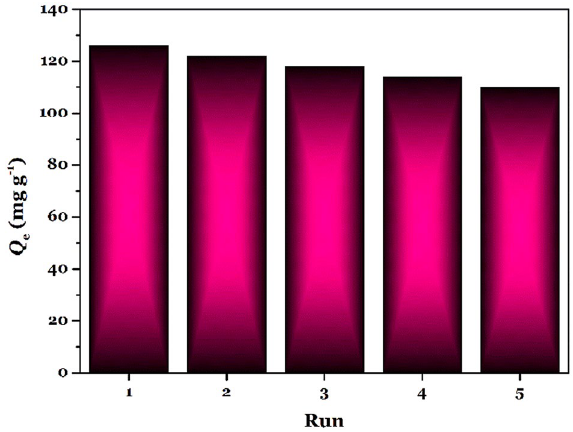
Figure 10. Regeneration of TSF-KCC-1.